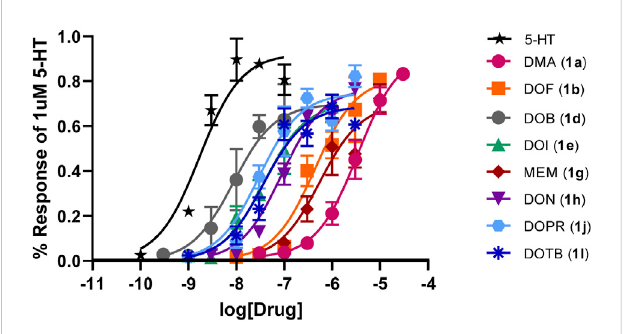
FIGURE 1 Concentration-response curves for eight agonists (Table 1) normalized to 1 µM of the endogenous ligand (5-HT) 5-HT 2B response.